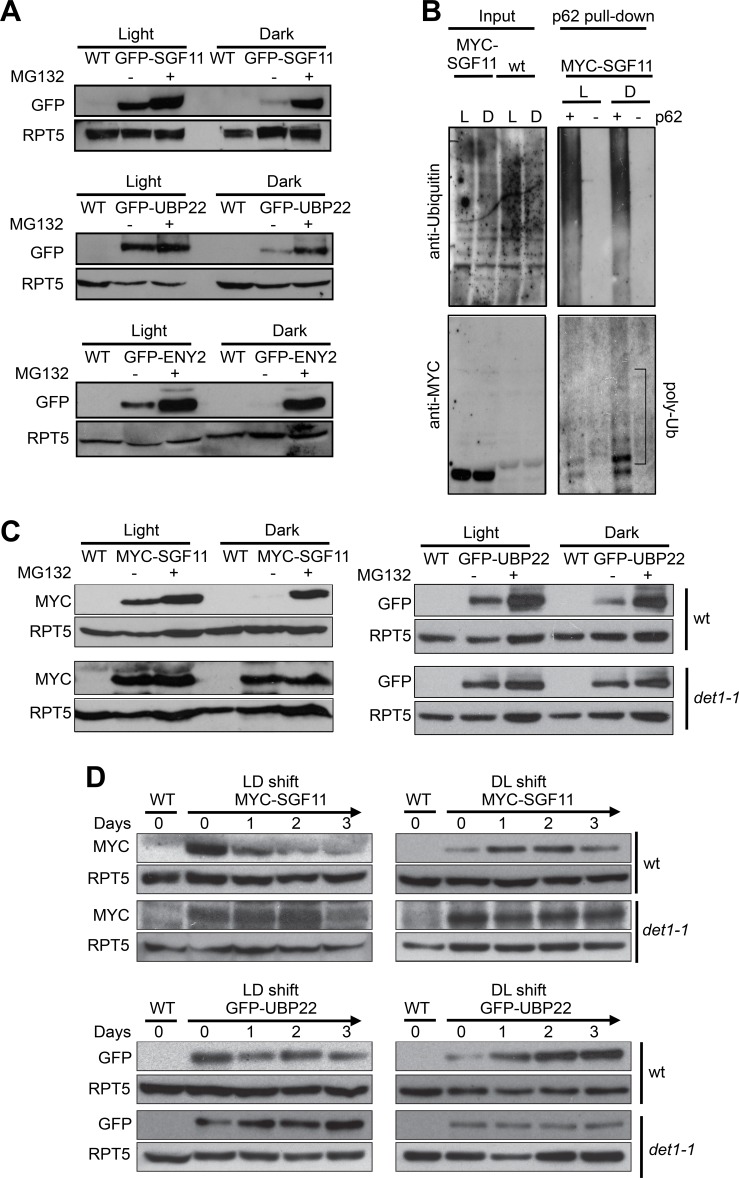
Light signaling controls the proteolytic degradation of the UBP22, SGF11 and ENY2 DUBm subunits.(A). UBP22, SGF11 and ENY2 DUBm components are degraded by the proteasome preferentially in darkness. Immunoblot analysis of GFP-tagged DUBm proteins in seedlings grown under continuous light or dark conditions. Prior to plant harvesting, seedlings were treated (+) or not (-) with 50 µM MG132 for 12 hr. (B) SGF11 is poly-ubiquitinated in vivo. MYC-SGF11 protein extracts from light (L)- and dark (D)-grown seedlings, treated (+) or not (-) with 50 µM MG132 for 12 hr, were incubated with p62 resin or with agarose resin as negative control. Ubiquitinated proteins are detected using anti-Ubiquitin antibody. Anti-MYC allows detection of MYC-SGF11 and its polyubiquitinated isoforms. Polyubiquitinated MYC-SGF11 signals are indicated (poly-Ub). (C) DET1 promotes the degradation of SGF11 and UBP22 preferentially in darkness. Analysis of the abundance of MYC-SGF11 and GFP-UBP22 proteins in wild-type and det1-1 seedlings grown under dark or light conditions. Prior to plant harvesting, seedlings were treated (+) or not (-) with 50 µM MG132 for 12 hr. (D) DET1 promotes UBP22 and SGF11 protein degradation upon a light-to-dark shift. In (A-D), immunoblots were performed on whole-cell protein extracts from seedlings grown under the indicated conditions.